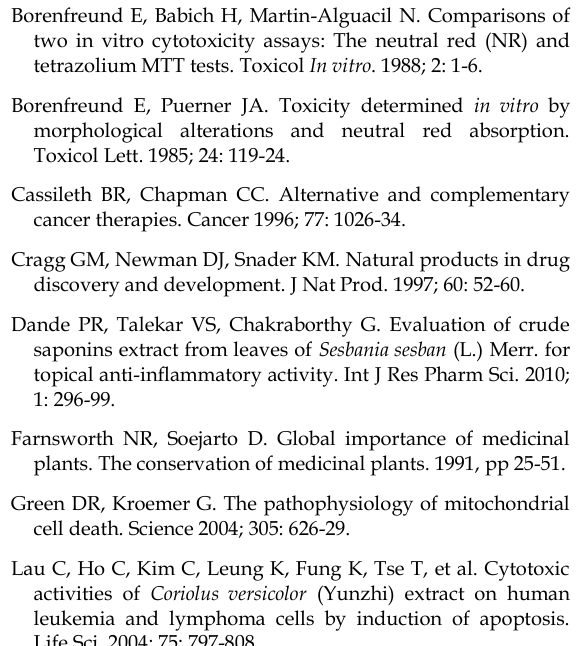
Figure 1: Morphological assessment of control (A and B) and Gaultheria trichophylla saponins (G. Sa) (10 µg/mL, final concentra- tion) treated MCF-7 cells (A2) and MDA MB-468 (B2) for 24 hours. The nuclei were stained with DAPI and observed under confocal